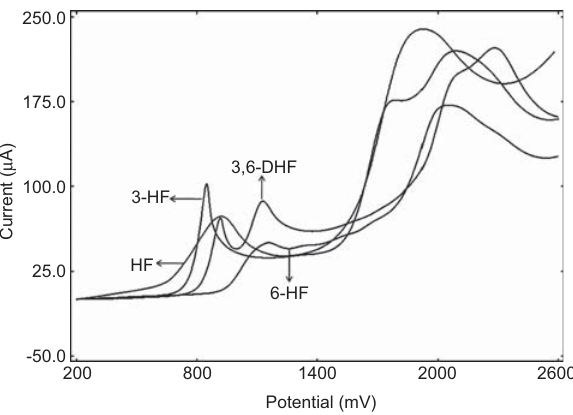
Figure 1 First scan cyclic voltammograms of HF, 3-HF, 6-HF, and 3,6-DHF in MeCN containing 0.1 m TBATFB and 1 m m fl avonoid between + 0.2 and + 2.6 mV potential range on the GC. Scan rate is 100 mV s -1 and vs. Ag/Ag + (10 m m )